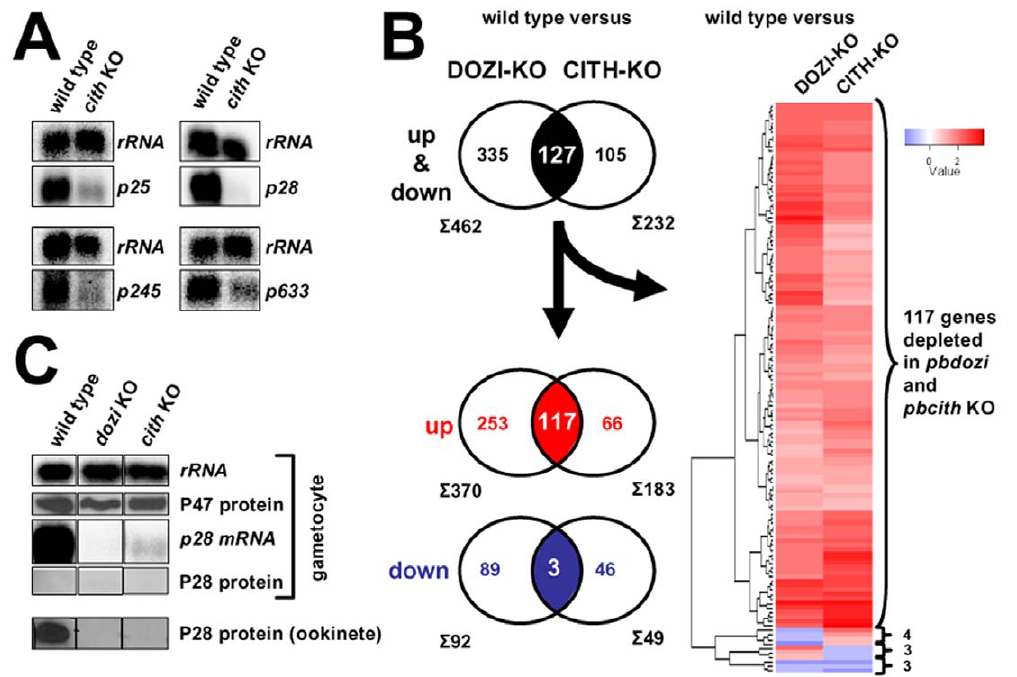
Figure 5. CITH and DOZI gene deletion mutant gametocytes suffer substantial mRNA loss. A Northern blot analysis of four translationally repressed transcripts in wild type and D pbcith mutants shows a clear de-stabilizing effect in the absence of CITH in gametocytes. B Venn diagrams of all 2-fold differentially expressed genes common to DOZI and CITH KO parasites. Hierarchical cluster analysis of the differentially expressed genes common to both lists. C Absence of DOZI or CITH does not result in the precocious translation of p28 mRNA into protein in female